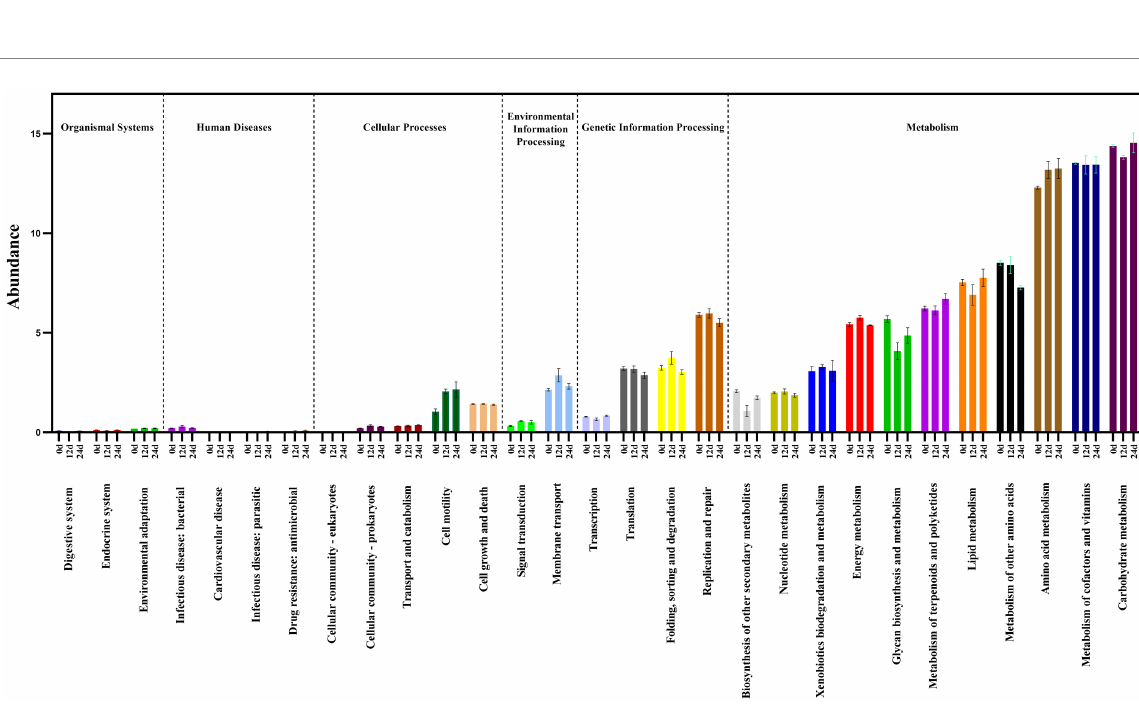
FIGURE 5 Prediction of 16S rDNA gene amplification functional pathways.